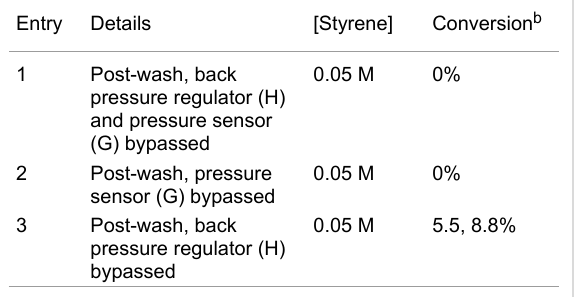
Table 3: Background reduction bypass experiments.